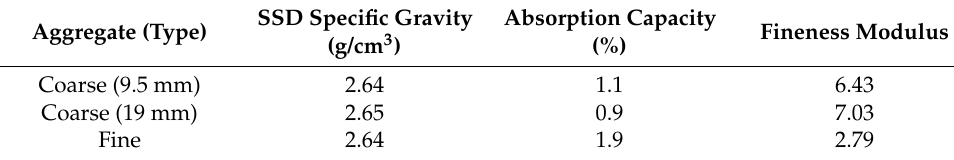
Table 2. Properties of the aggregates used in the concrete